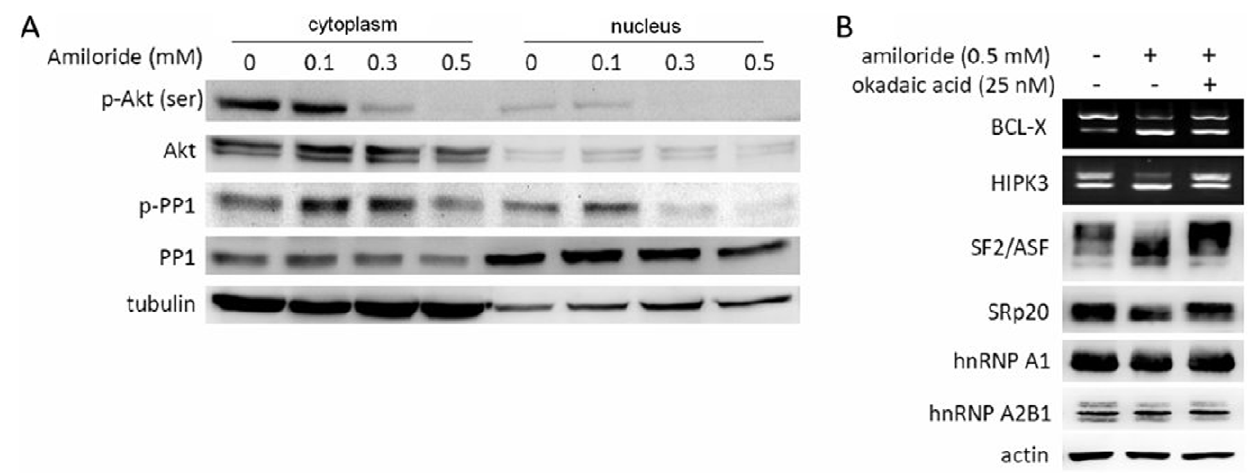
Figure 4. Phosphorylation of Akt kinase (activation) and PP1 phosphatase (inactivation) in relation to amiloride-altered AS mechanisms. (Panel A ). Western blots show significant decreases of cytoplasmic p-Akt, nuclear p-Akt and nuclear p-PP1 in Huh-7 cells treated with amiloride at 0.3 mM and above. ( Panel B ) RT-PCR and western blot analyses show that pre-treatment with a PP1 inhibitor, okadaic acid, abrogated the amiloride effects on the BCL-X and HIPK3 oncogenic RNA splicing, the phosphorylation of ASF2/ASF splicing factor and the level of SRp20 in Huh- 7 cells.